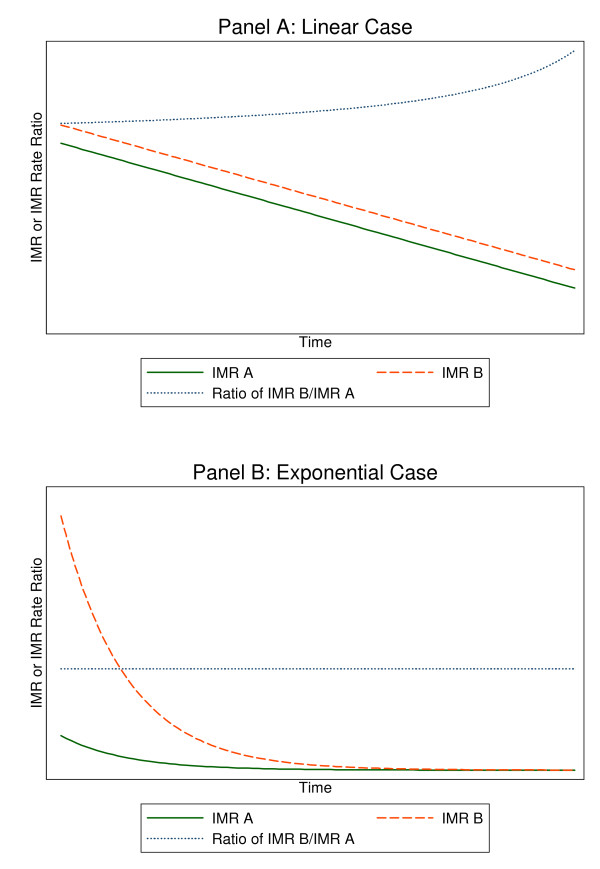
Graphical depiction of how relative rate ratios evolve over time. In panel A, two populations begin a linear process of IMR decline that maintains an equal gap and a constant decrement in IMR at each period. In Panel A, the rate ratio increases asymptotically as the lower rate ratio approaches zero. In panel B, the populations experience exponential decline in IMR with the same coefficient of decay but with population B starting from a higher infant mortality. In Panel B, the gap declines to nearly zero, but the rate ratio remains constant.